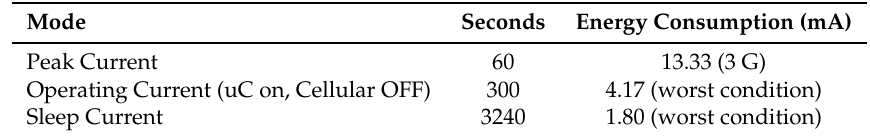
Table 6. Particle electron energy consumption in the normal mode.